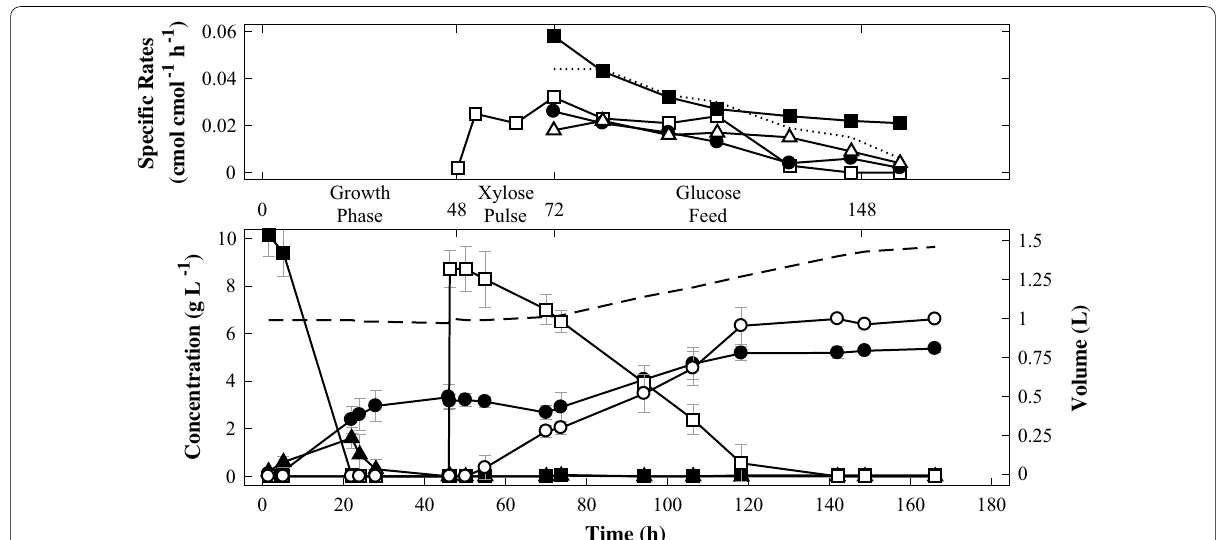
Fig. 3 Fed‑batch experiments with strain TMB4530 ( xylB , xylD , xylX , xylA ). d ‑Glucose (filled square), biomass (filled circle), ethanol (filled triangle), d ‑xylose (square), d ‑xylonate (circle), CO 2 (triangle) and liquid volume (straight line). The dotted line represents the sum of specific productivity of biomass and CO 2 . All experiments were performed in biological duplicates and standard deviations are indicated with error